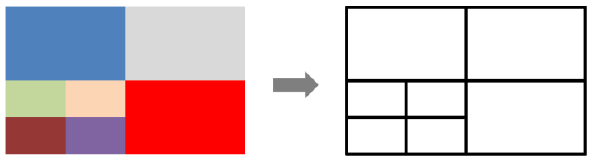
Figure 1. Principles of the Quad Tree clutter: the quad tree goes deeper as long as the colors in the cell are not homogeneous